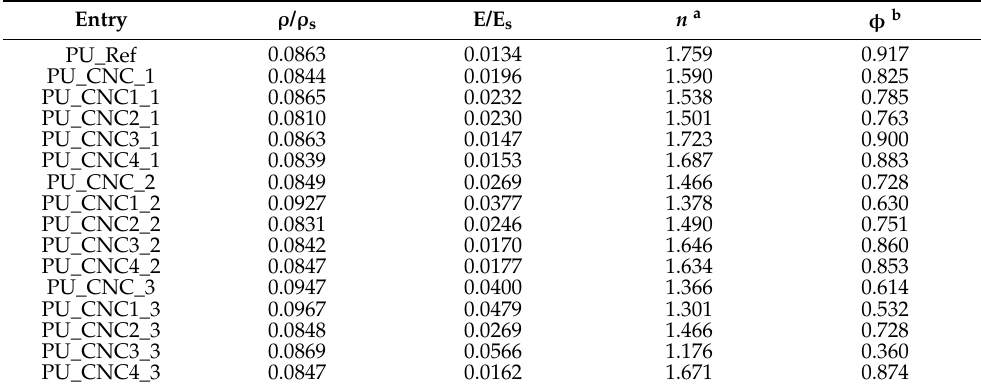
Table 7. Parameter value of PU